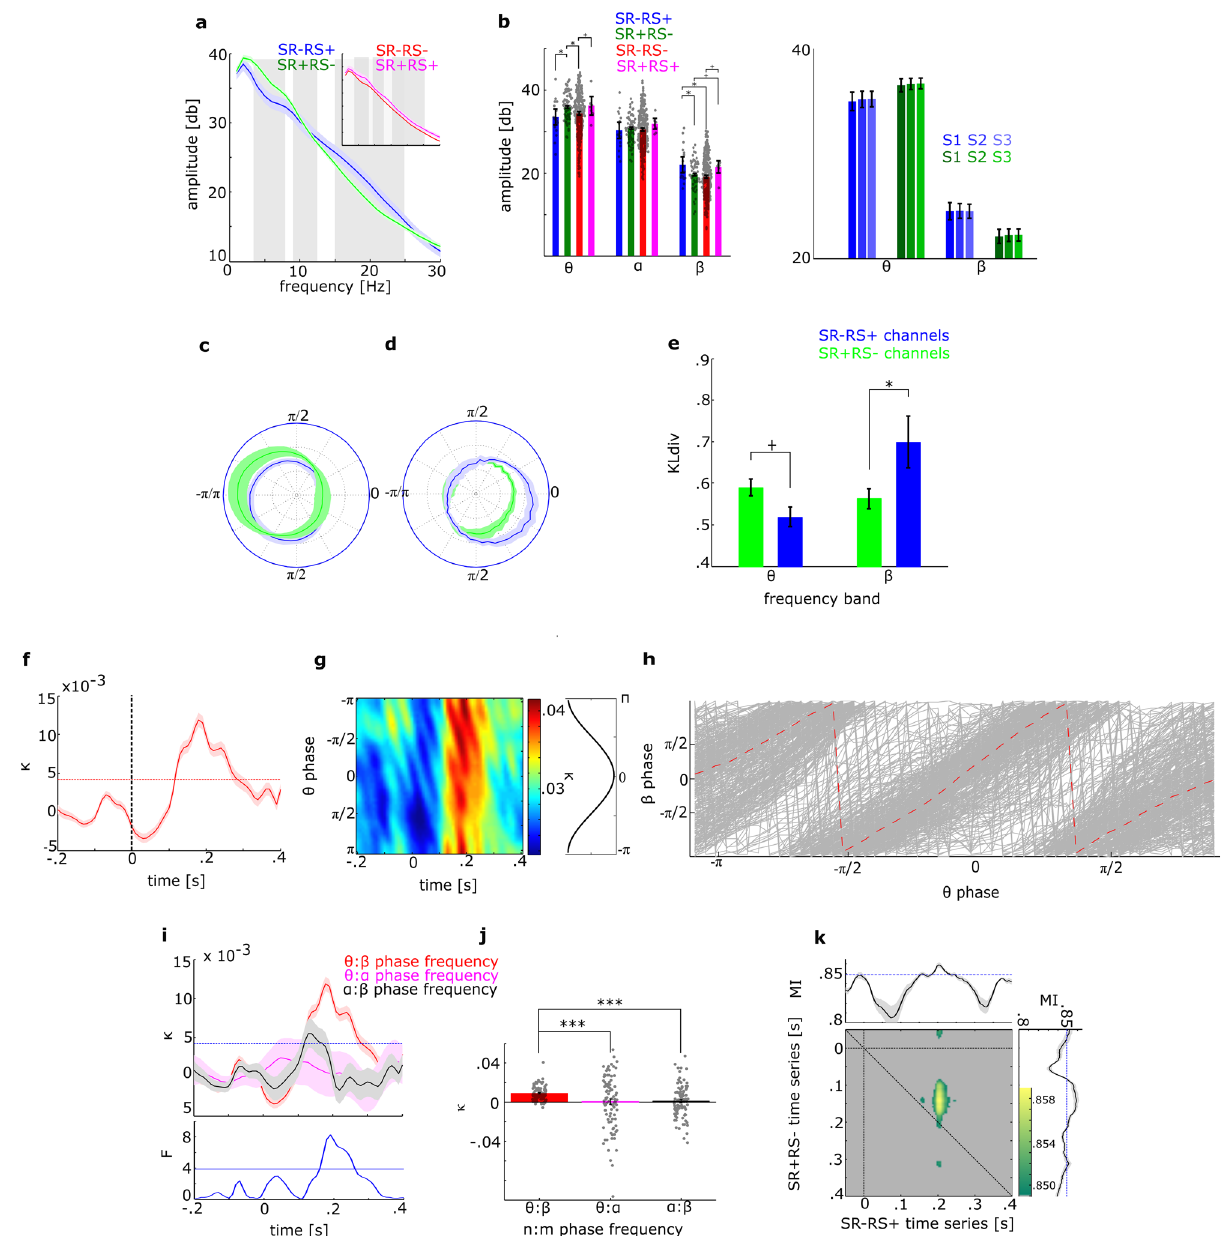
Fig. 3 Stimulus response and repetition suppression show complex spectral interactions. a Power spectral density (PSD) for SR – RS + and SR + RS – channels (inset shows PSD for channels showing both/neither effect). b Spectral power averaged within three canonical frequency bands, showing higher β power in RS + (SR + RS + , SR – RS + ) than RS – (SR + RS – , SR – RS – ) channels and higher θ power in SR + (SR + RS – , SR + RS + ) compared to SR – (SR – RS + , SR – RS – ) channels. No differences between channel sets were found within the α band (unsaturated color bars), gray dots represent single data. The right panel shows spectral power for the three consecutive standard trials separately, for the SR-RS + channels (blue) and SR + RS- channels (green) separately. c , d HFA modulation by θ ( c ) and β ( d ) for SR – RS + (blue) and SR + RS – (green) channels. e Kullback – Leibler divergence of θ and β for SR – RS + and SR + RS – . f , g modulation of concentration index κ , indicating transient θ : β interaction, averaged across phases ( f , the dashed horizontal red line shows the signi fi cance threshold) and for each θ phase ( g ). h θ -phase: β -phase coupling at κ max , gray lines represent pairwise combinations, red dashed line shows the average across all pairs. i the κ -comparison between θ : β , θ : α , and α : β (bottom: ANOVA F values). j Post hoc comparisons of θ : β , θ : α , and α : β , gray dots represent single data. (*** indicates p < 0.001) k Directed information propagation from SR + RS – to SR – RS + . In all panels, the shaded error margin around lines indicates the standard error across SR peaks earlier than HFA RS effects, and HFA SR predicts HFA RS. phase – amplitude coupling (PAC) than sites with no SR, and RS sites showed stronger β power and stronger β :HFA PAC than sites showing no RS. Finally, we show that the two processes interact - the two types of sites show phase-phase coupling decrease to repeated stimulation. Previous ECoG studies have between their dominant theta and beta frequencies. Further, HFA